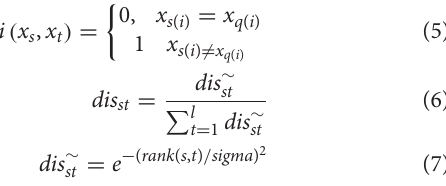
FIGURE 2 | Clustering methods used.